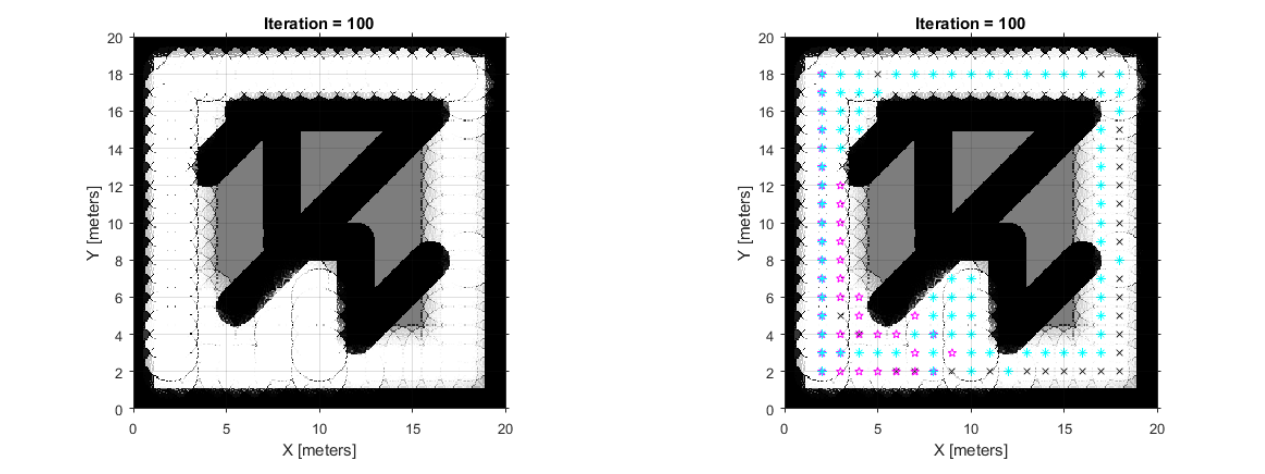
Figure 8. Multi-robot Exploration using Whale